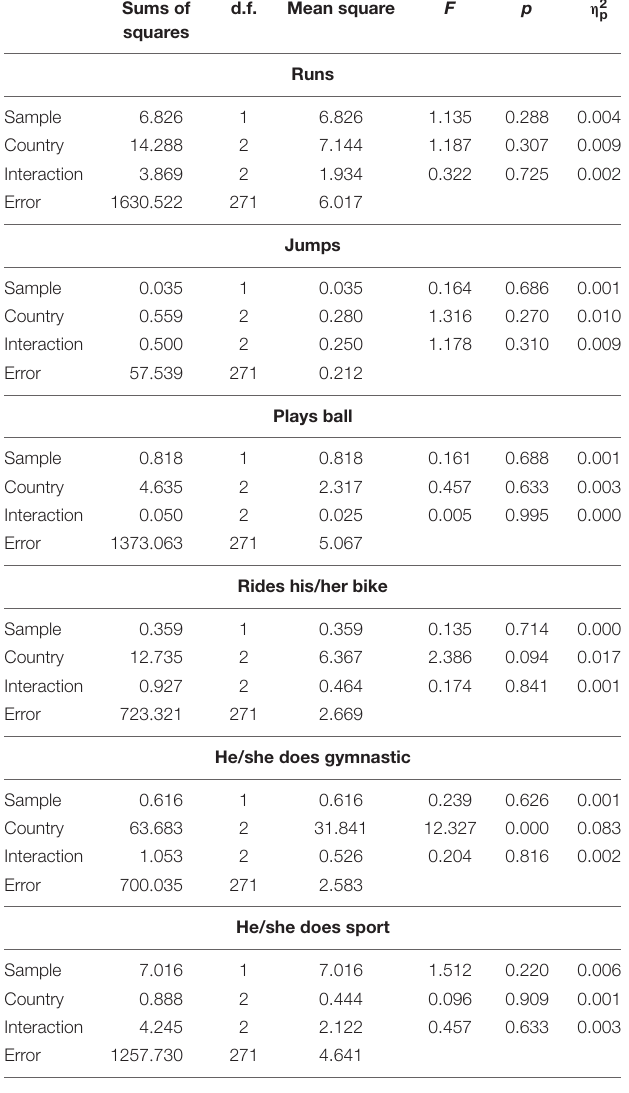
TABLE 9 | Shapiro–Wilk normality test and Levene test. Activity